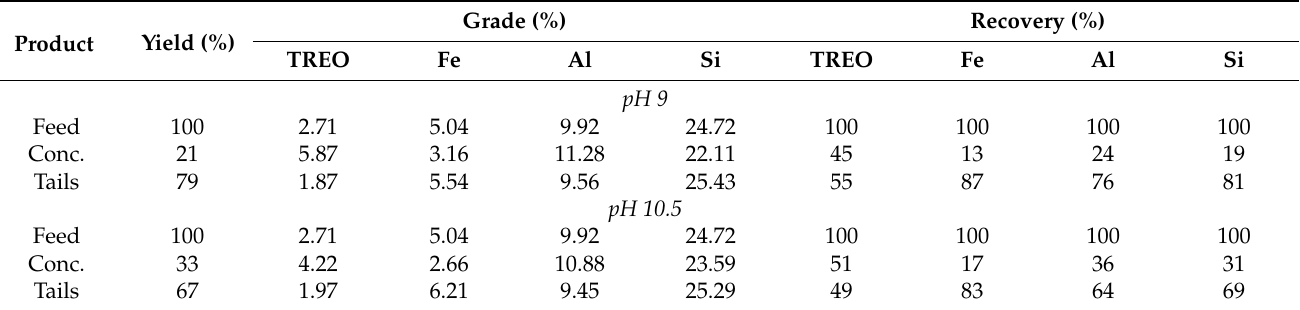
Table 4. Summary of results obtained for Flowsheet II at pH 9 and 10.5.